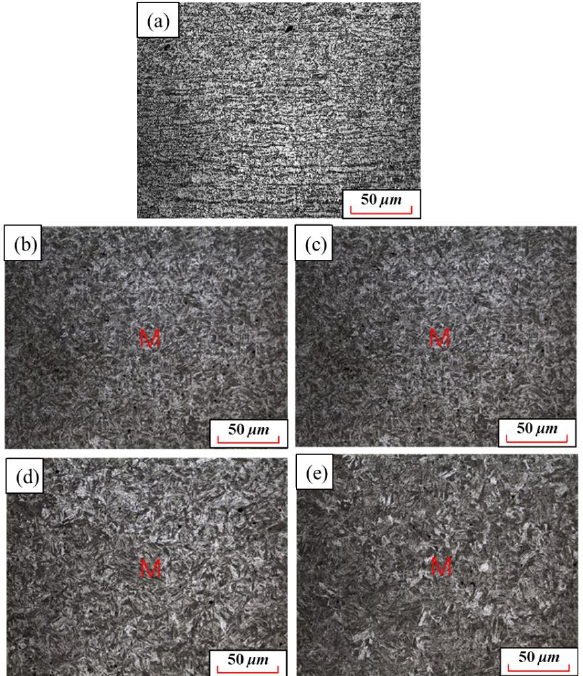
Figure 12. Microstructures of 22MnB5NbV steel at different holding time: ( a ) 1 min; ( b ) 3 min; ( c ) 5 min; ( d ) 7 min; ( e ) 10 min.